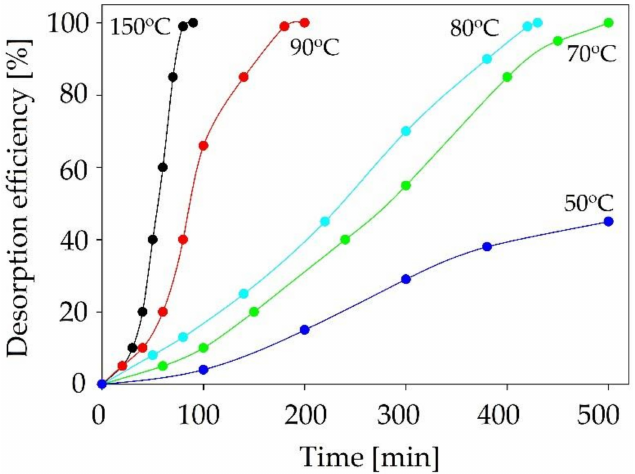
Figure 15. The effect of temperature on C:DA (1:1) in the desorption